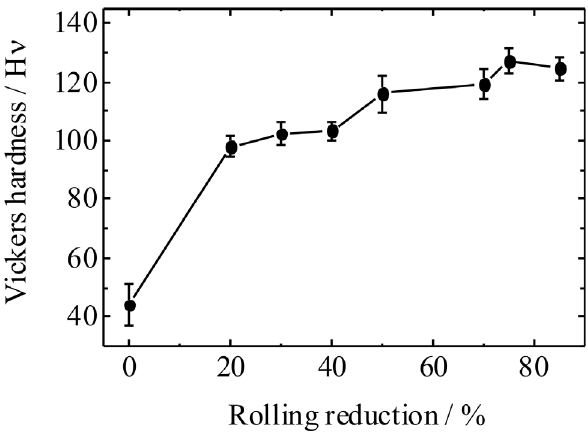
Figure 1: Vickers hardness of cold-rolled pure copper sheets at different deformation